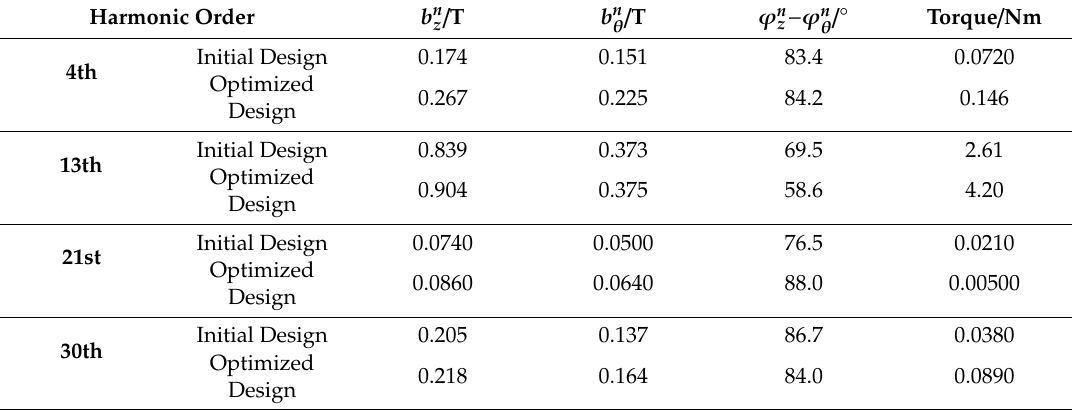
Table 11. Amplitudes, the phase di ff erences and torque due to the air-gap flux density at the radius of R m5